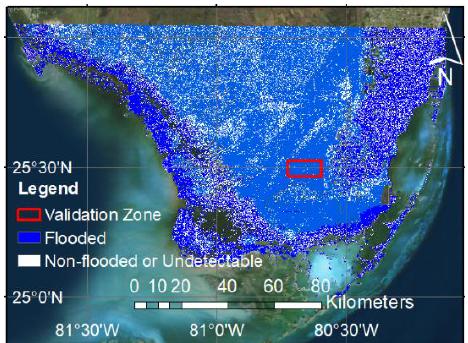
Figure 10. The validation zone within the red rectangle frame overlaying with extent of flooding map.